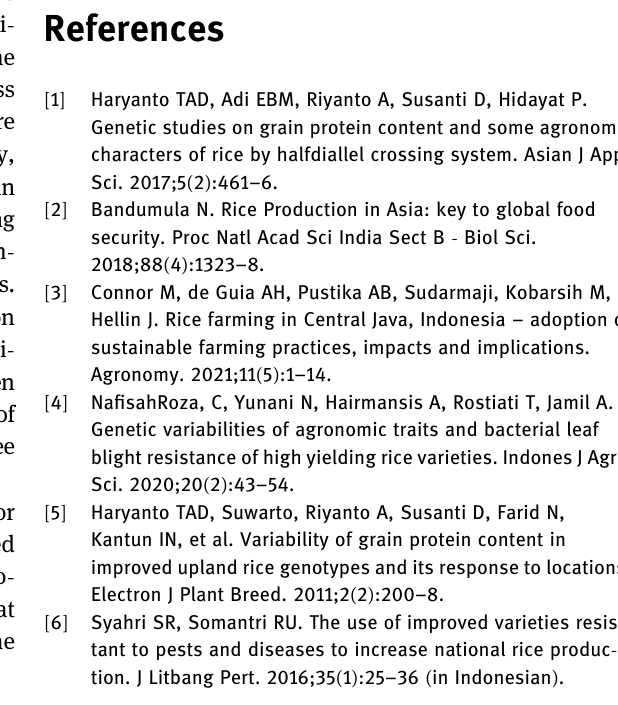
* Signi fi cantly di ff erent at the level of 5%, ns = not signi fi cantly di ff